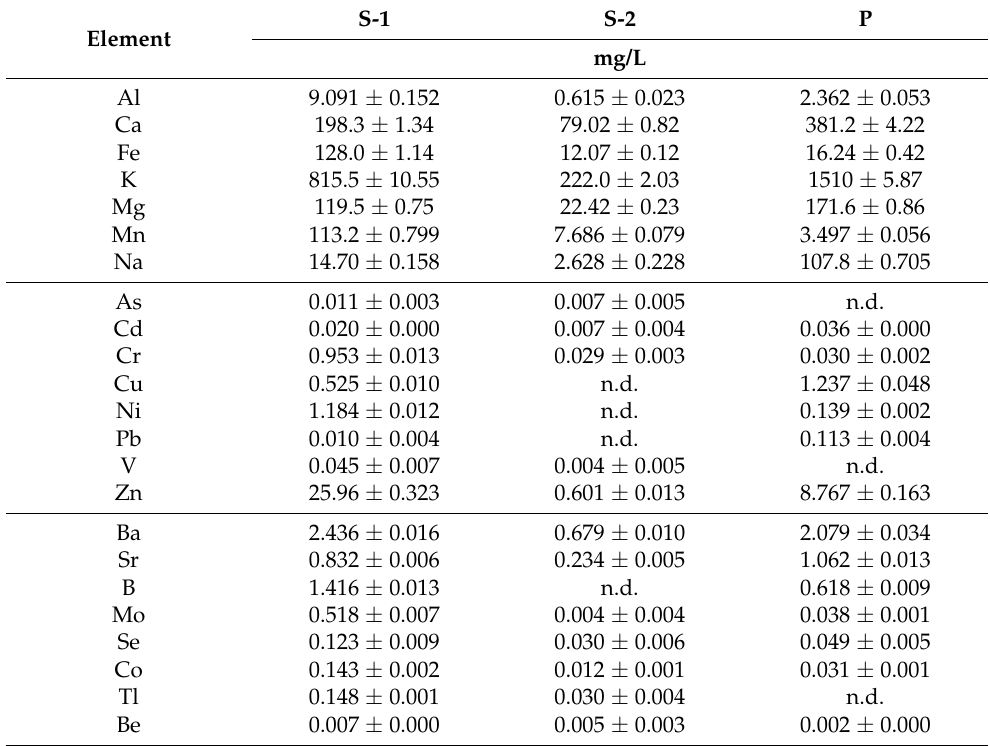
Table 3. Minor and trace element concentration of spruce-based (S-1 and S-2) and of poplar-based (P) press waters. For Sb, Ag, Ti, Li and Bi, all values were below the detection limit and thus not detected (n.d.). Mean values ± standard deviation (n = 4). The order of the elements was selected in accordance with IS0